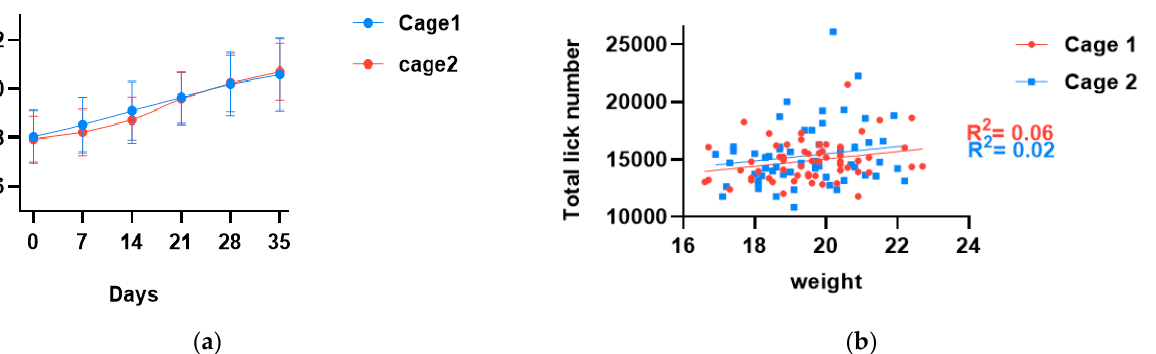
Figure 3. ( a ) Change in weight of animals during the study. Data represent means ± SD. After 5 weeks, animals gained 2.65 g in both experiments ( p -value < 0.05) ; ( b ) number of licks normalized for the body weight of individuals; linear regression analysis shows no relation between weight and total number of the licks.